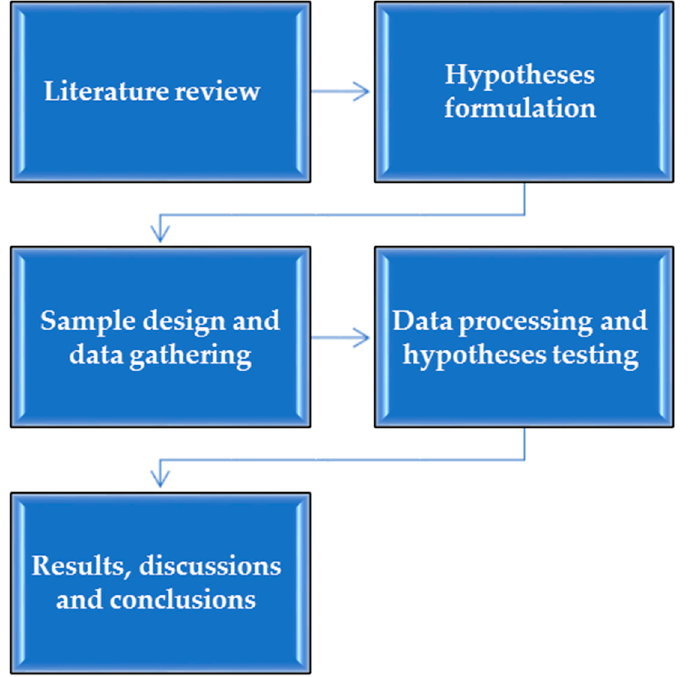
Figure 2. Research process. Source: own construction.